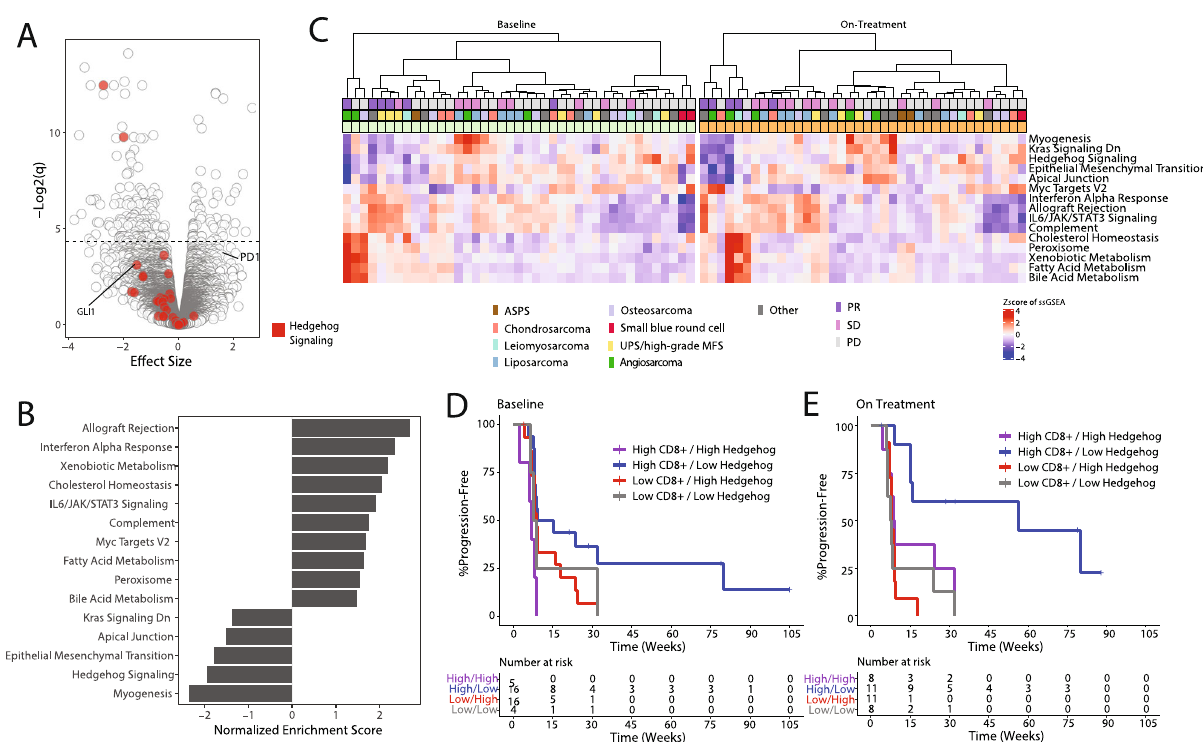
Fig. 3 Differentially expressed pathways in partial responders. A Volcano plot of differential expression between partial responders ( n = 7 patients) and non-responders ( n = 41 patients). Model included trial cohort, patient, purity, and sample time point as covariates. Points represent genes. Genes in Hallmark hedgehog pathway are highlighted in red. B Top 10 upregulated and all 5 downregulated Hallmark pathways between partial responders ( n = 7 patients) and non-responders ( n = 41 patients). Analysis performed using fgsea in R. All pathways are signi fi cantly enriched (BH adjusted p < 0.05). C Heatmap of ssGSEA scores of baseline ( n = 41 patients) and on-treatment ( n = 38 patients) expression in individual patients for top enriched pathways in ( B ) using the leading-edge genes from the fgsea analysis. D , E . Kaplan – Meier plot of progression-free survival of patients divided into four groups depending on the amount CD8 + T cells and ssGSEA score of hedgehog pathway enrichment across cohort (high versus low, split by median). Scores derived from expression at baseline in ( D ) and on-treatment samples in ( E ). Note, cross-validation analysis does not output p values. Source data are provided as a Source Data fi